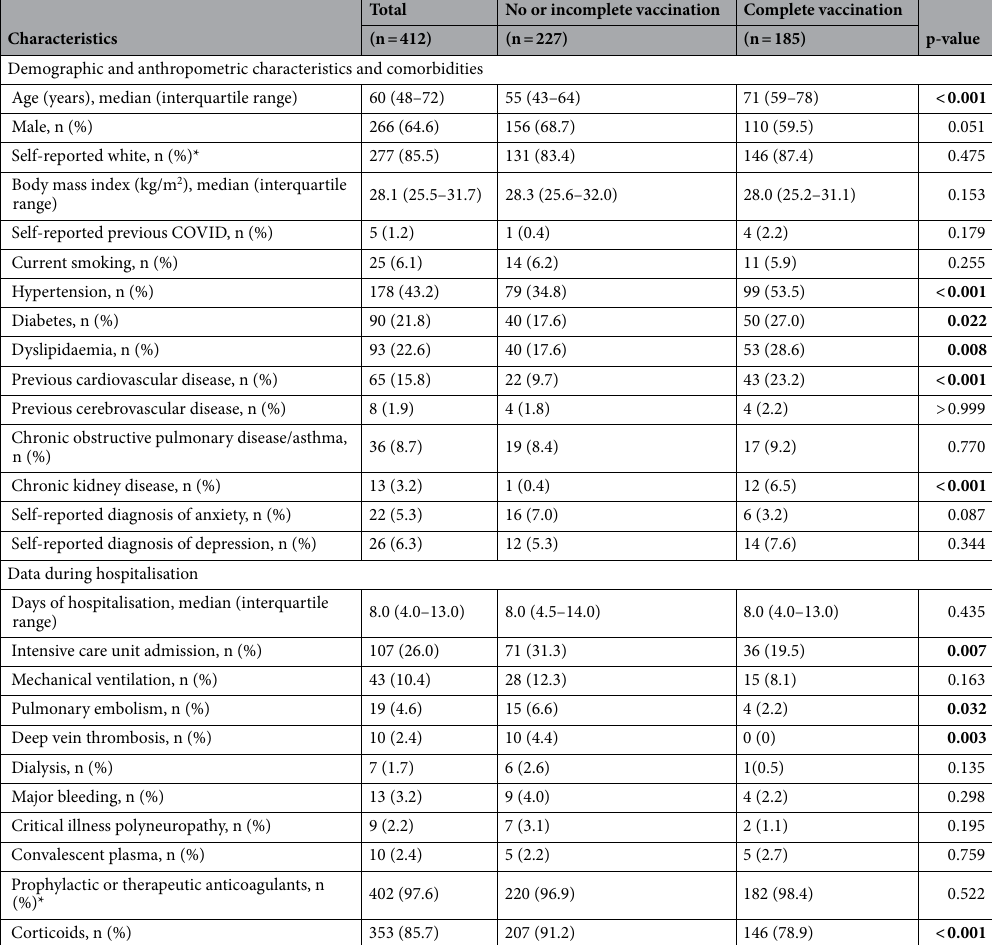
Table 1. Characteristics of patients discharged after hospitalisation for COVID-19 stratified according to vaccination status. *n = 324 (some patients refused to report this variable). Bold numbers indicates variables with statistical significance.